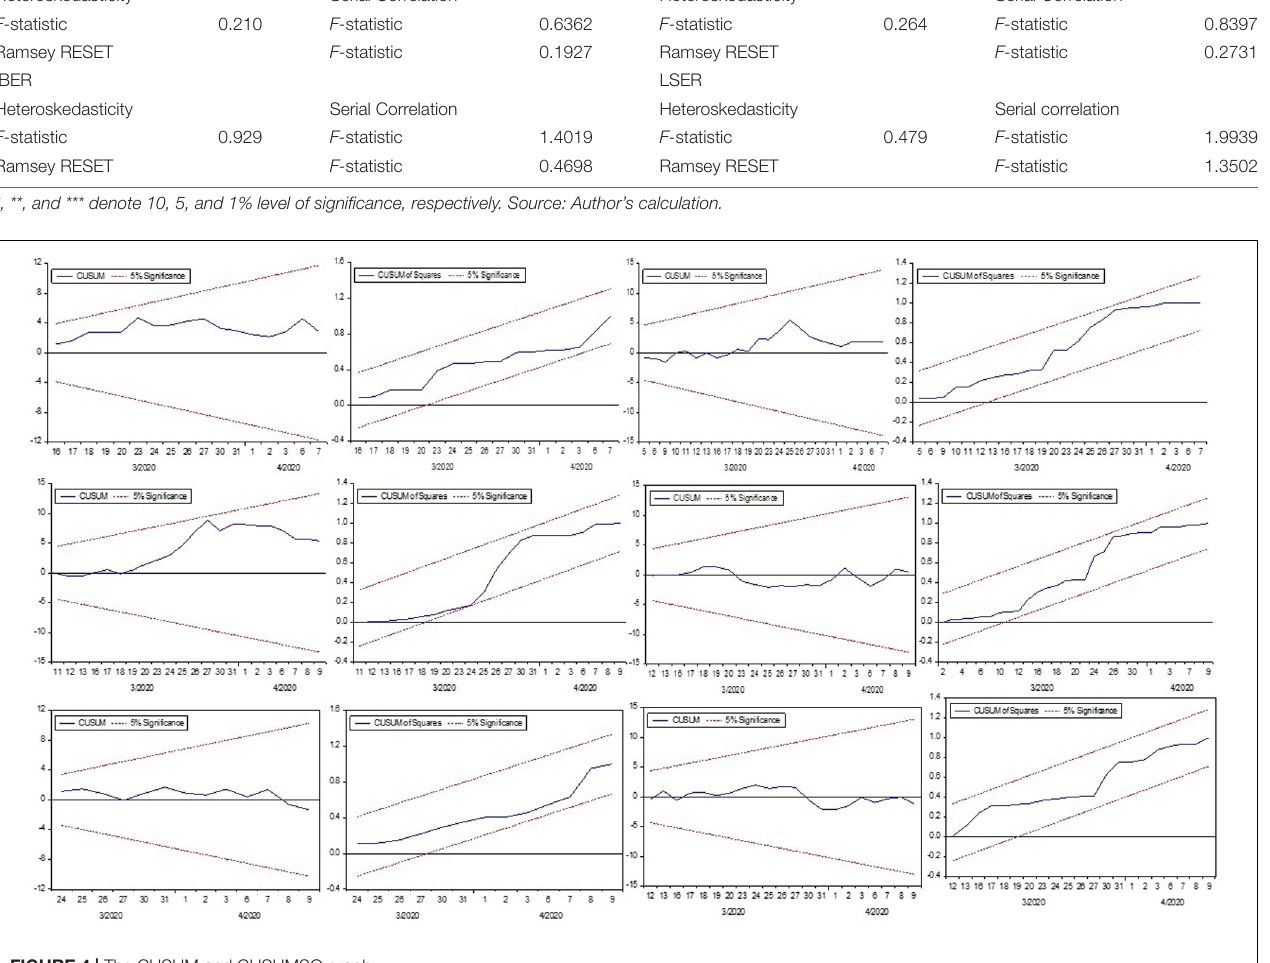
FIGURE 4 | The CUSUM and CUSUMSQ